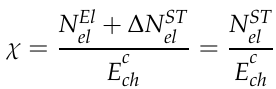
Figure 11. The energy efficiency for the power unit with superstructure added as a function of gas turbine rated power at a minimum steam boiler output of 133.3 kg/s and gas turbine operating at 60% of its rated power.